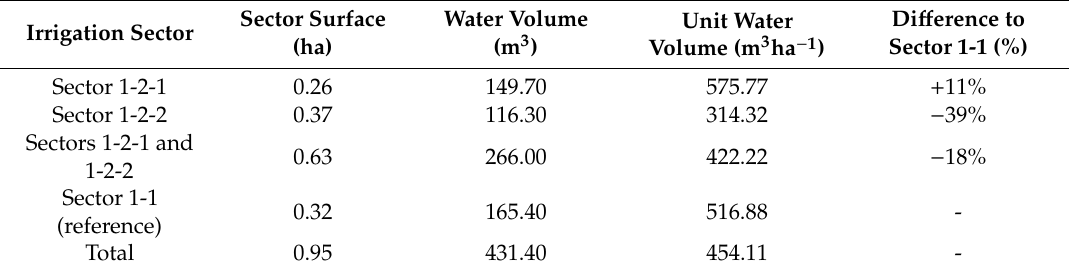
Table 6. Water volumes supplied to each irrigation sector of the field.